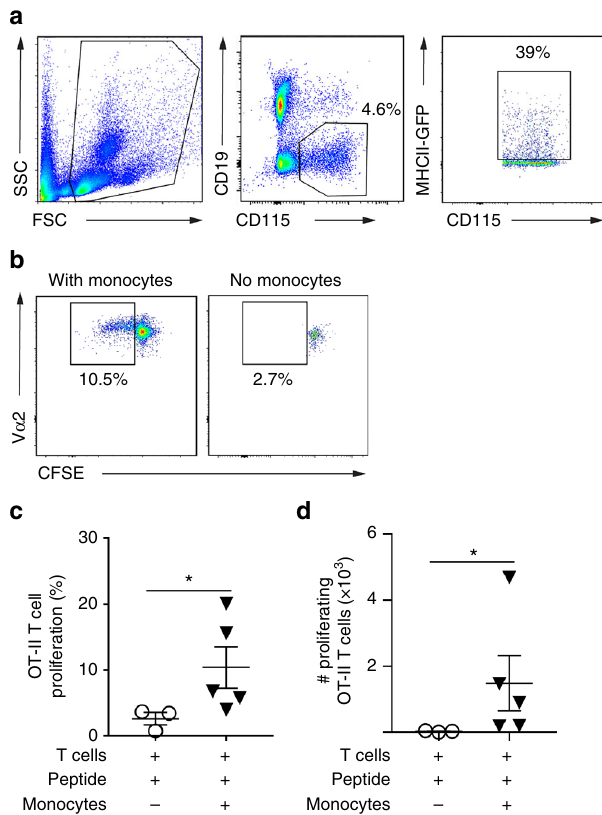
Fig. 7 MHCII + monocytes are capable of inducing CD4 + T-cell proliferation. MHCII + monocytes were sorted from the blood of MHCII- GFP mice and used as antigen-presenting cells in in vitro CFSE dilution T- cell proliferation assays with OT-II cells. a Flow cytometry plots showing gating strategy used to isolate MHCII + monocytes, initially gating on forward and side scatter pro fi les (left panel), then identifying monocytes (CD19 − CD115 + — central panel), then selecting GFP + cells within the monocyte population (right hand panel). b − d OT-II cell proliferation as assessed via CFSE dilution. b Representative FACS plots of proliferating OVA-speci fi c V α 2 + OT-II CD4 + T cells (gated as shown in Supplementary Fig. 7) shown for T cells cultured with peptide-pulsed MHCII + monocytes vs T cells with peptide alone. CFSE dilution (proliferation) is observed in the presence of MHCII + monocytes but not in the absence of monocytes. Inset numbers represent the average proportion of cell populations over fi ve individual experiments. c , d Group data from individual experiments performed with T cells and OVA peptide alone, or with T cells, OVA peptide and MHCII + monocytes, showing OT-II cell proliferation as % ( c ) and number ( d ) of OT-II cells. * P < 0.05 via Mann − Whitney